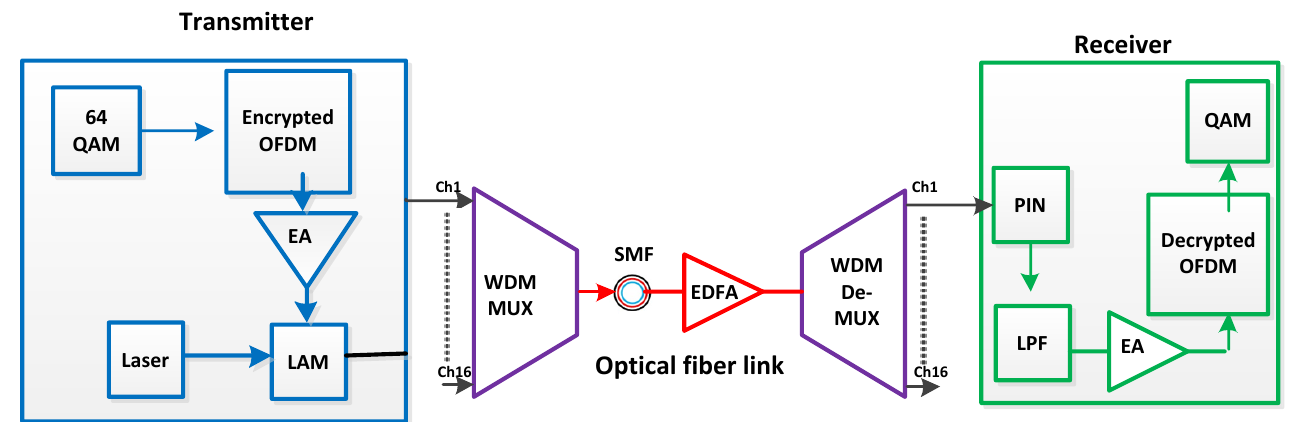
Figure 1. Enhanced physical layer security proposed ON against security